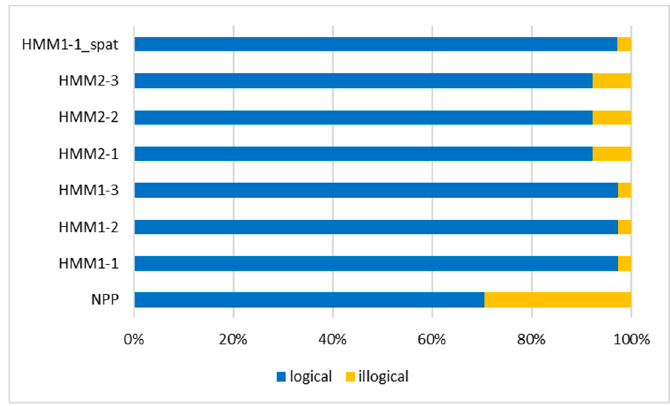
Figure 8. 100% stacked bar chart showing the proportion of illogical transitions, 2007–2015.